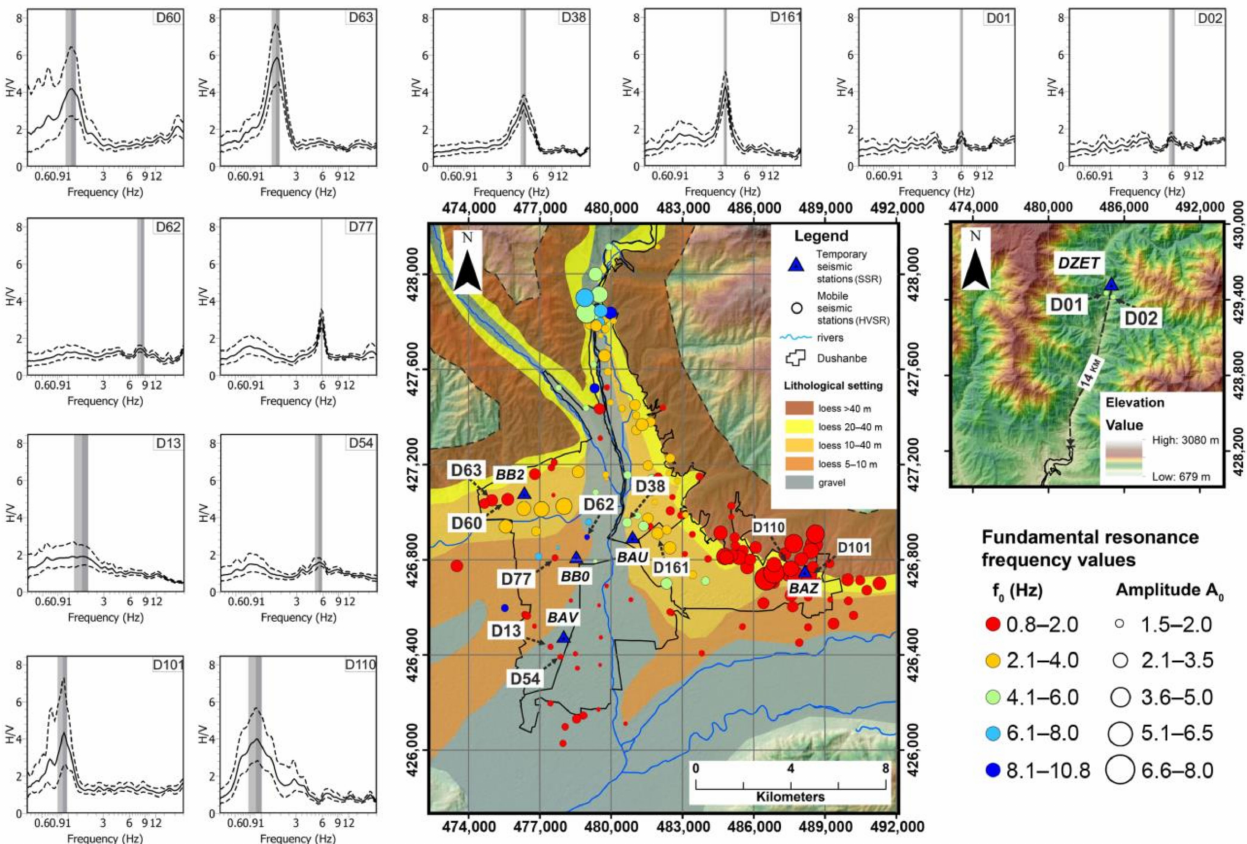
Figure A2. Map of the Dushanbe city showing the locations of the temporal seismic stations for SSR, mobile seismic stations (HVSR), lithological settings, and information about the fundamental resonance frequency and amplitude values. The inlet on the right shows the location of the reference station. Selected HVSR curves from mobile seismic stations near to temporal seismic stations are shown as